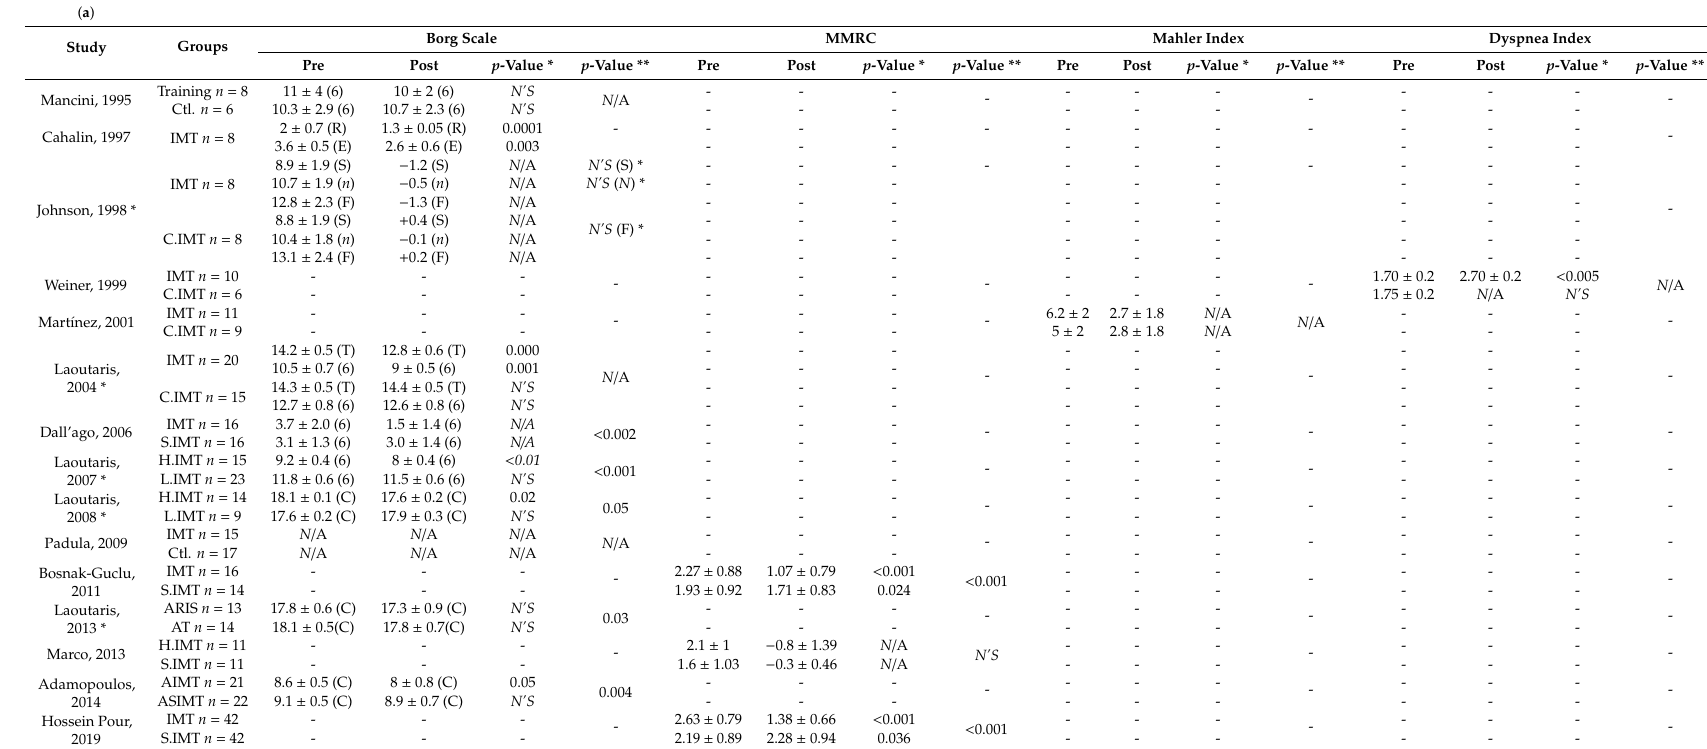
Table 3. a. Dyspnea; b.